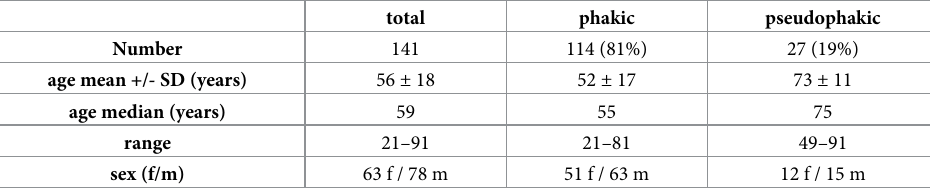
Table 1. Descriptive data of the included subjects.